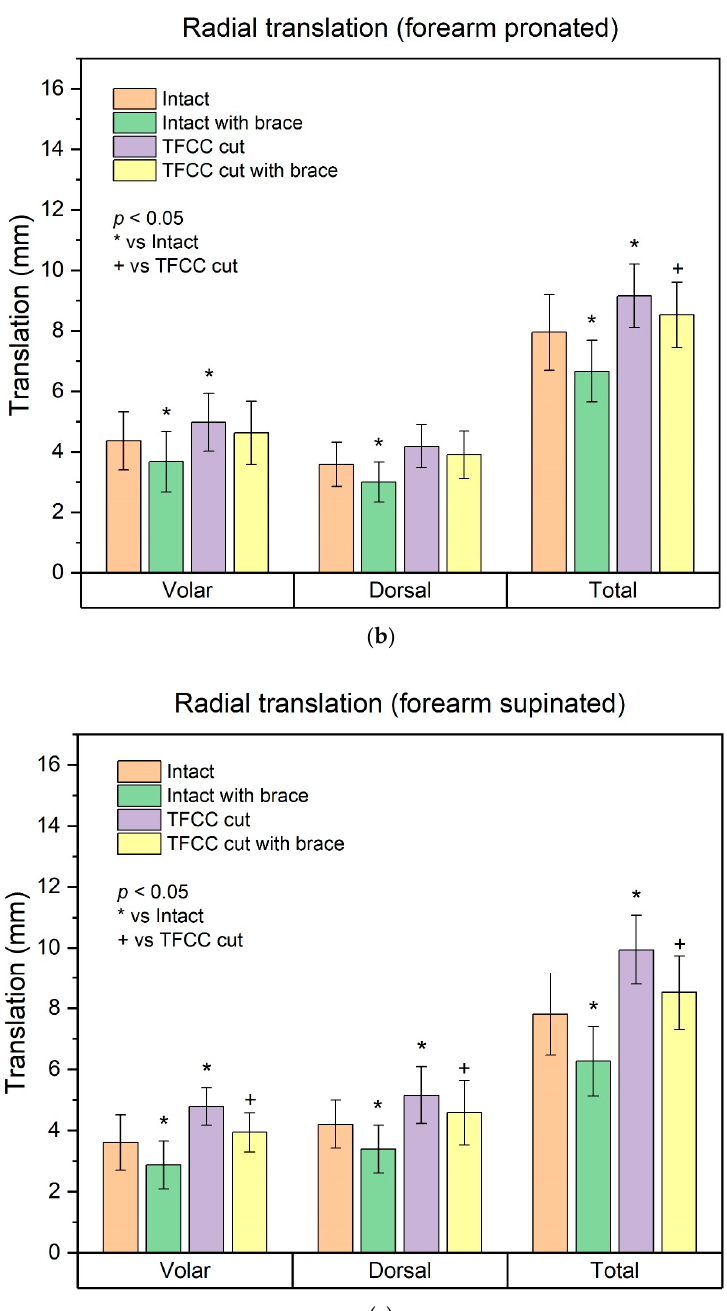
Figure 3. The amount of DRUJ translation in each condition. ( a ) Radial translation (neutral forearm rotation); ( b ) Radial translation (forearm pronated). ( c ) Radial translation (forearm